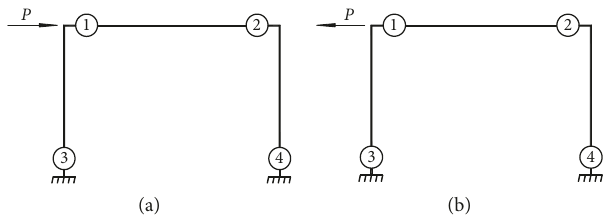
Figure 5: The order of KJ-2 plastic hinge formation: (a) right horizontal load, (b) left horizontal load.